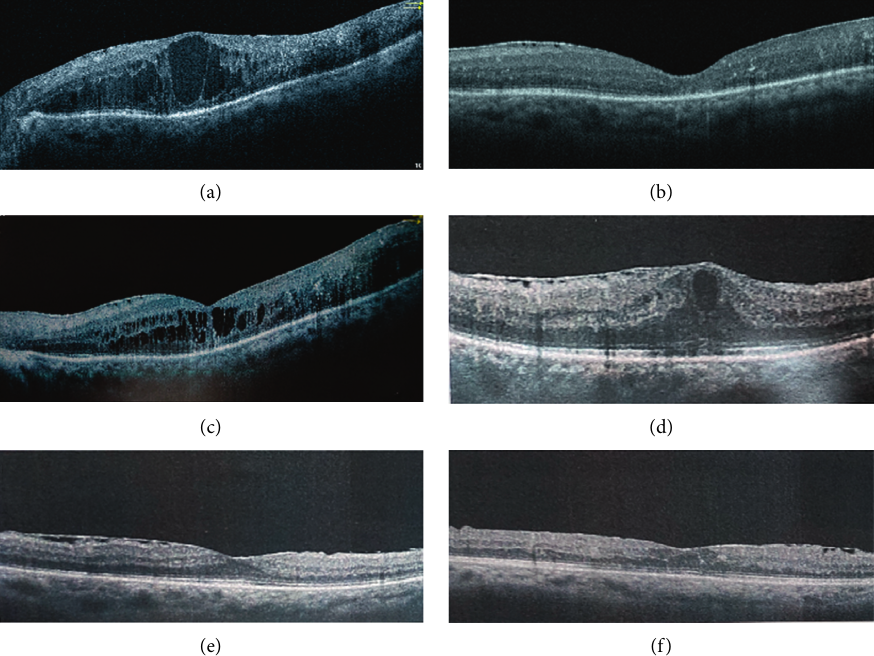
Figure 3: Example of CFTchanges measured by OCTin both groups at baseline, 1, and 3 months. IVTA group (a)–(c). SCTA group (d)–(f).